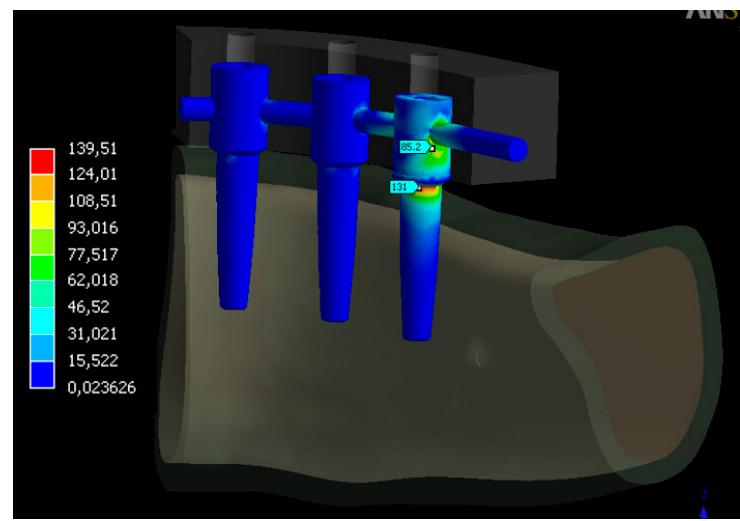
Figure 6. von Mises stress in the implant, abutment and metallic structure in group M2 in MPa.